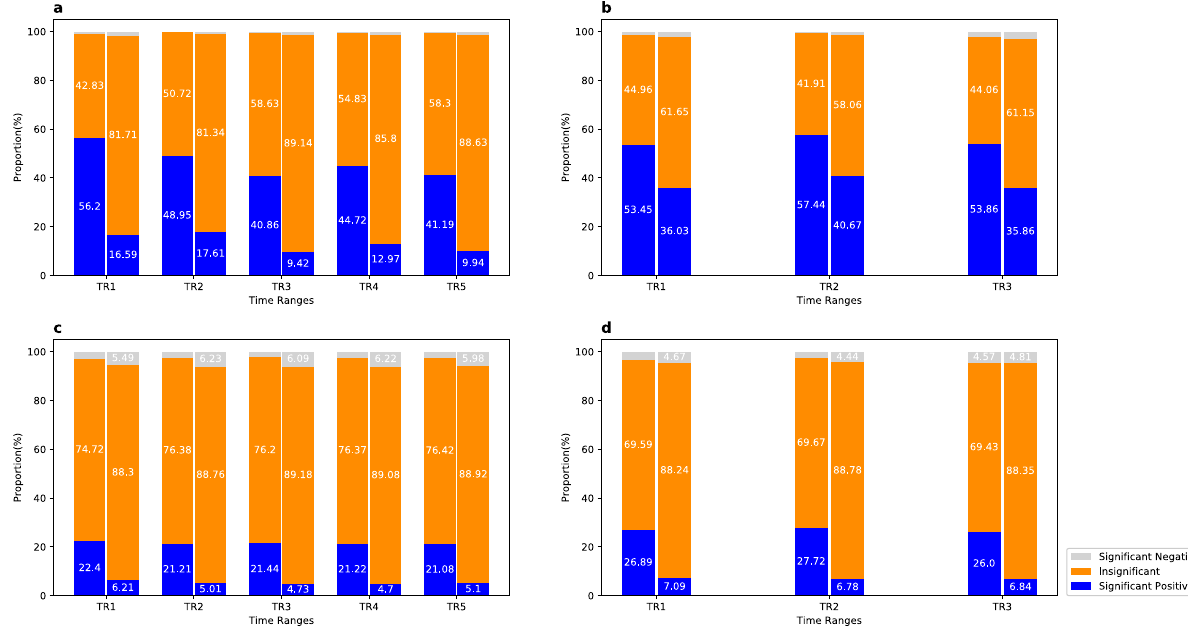
Figure 4. Proportions of spatial correlations and spatial partial (SP) correlations of travel speeds in different time ranges for both directly and indirectly adjacent cases. The three colors in each bar represent the average proportions from different time periods within a specific time range, for significant positive, insignificant, and significant negative spatial or SP correlations, respectively. The two bars for each time range represent the directly adjacent (left) and indirect adjacent cases (right) respectively. We provide the average results of different time periods here because different time periods have little effect on spatial and SP correlation (see Supplemental Tables S4 and S5). ( a ) Urban road network (spatial). ( b ) Freeway network (spatial). ( c ) Urban road network (SP). ( d ) Freeway network